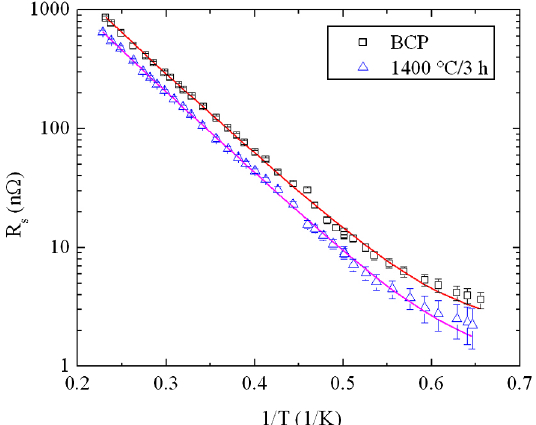
FIG. 9. R s vs 1 =T measured after BCP and after HTat 1400 (cid:1) C . ð T Þ þ R . Solid lines are least-square fits with R s ð T Þ ¼ R BCS res The values of the fit parameters are (cid:2) =kT c ¼ 1 : 87 (cid:3) 0 : 02 , ‘ ¼ ¼ ð 2 : 0 (cid:3) 0 : 3 Þ n(cid:1) after BCP and (cid:2) =kT ¼ ð 303 (cid:3) 85 Þ nm , R c res ¼ ð 1 : 0 (cid:3) 0 : 2 Þ n(cid:1) after HT 1 : 90 (cid:3) 0 : 01 , ‘ ¼ ð 76 (cid:3) 17 Þ nm , R res at 1400 (cid:1) C